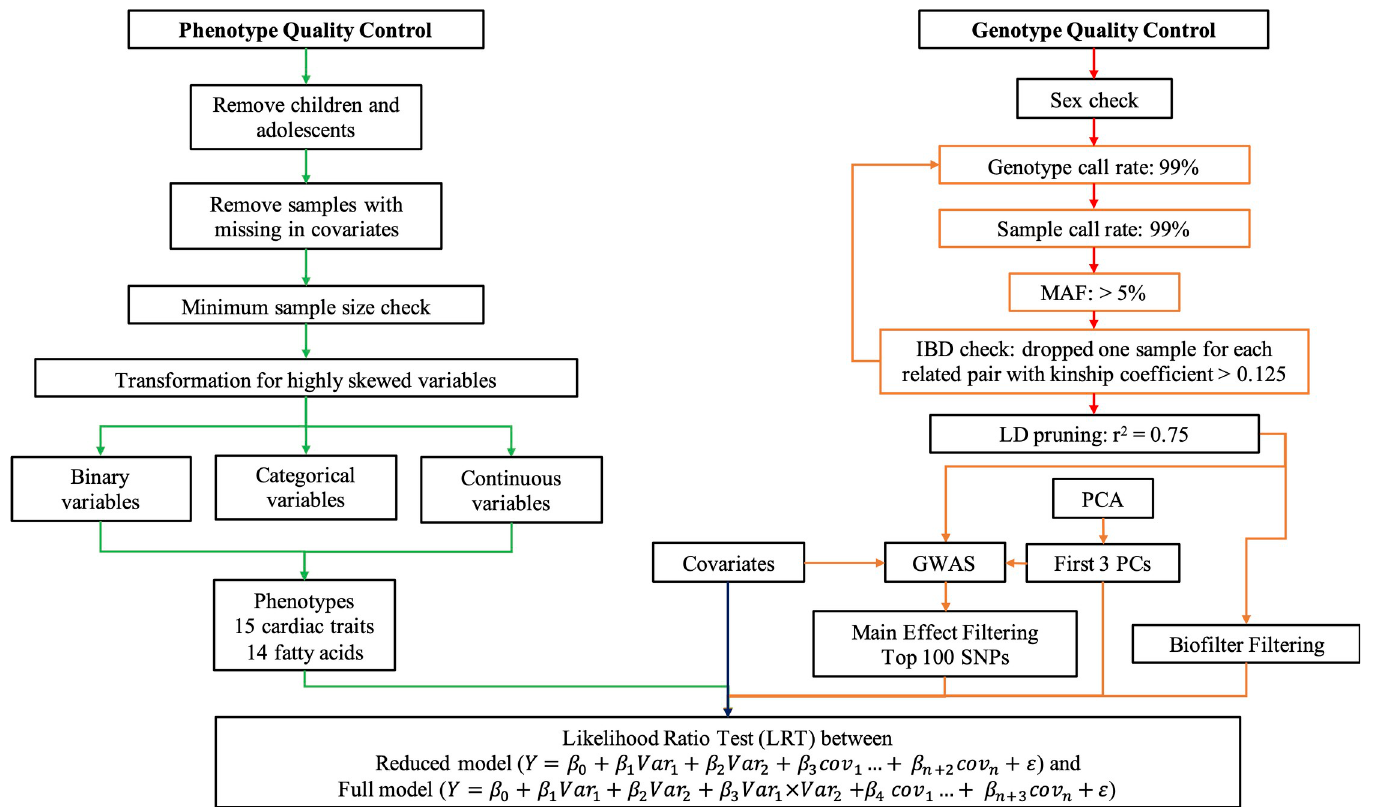
Fig 1. Design of quality control and gene-gene interaction analysis. The phenotype quality control was performed in CLARITE software [15]. The genotype quality control and the principle component analysis (PCA) were performed in PLINK 1.90 [13]. The genome-wide association study (GWAS) and gene-gene interaction (G × G) were performed in PLATO [16]. SNP-SNP interaction models were assessed using a likelihood ratio test (LRT) between the reduced model and full model, where Var1 and Var2 are the potential SNP predictors of interest, Y is the phenotype, cov s are the covariates, and ε is the error.